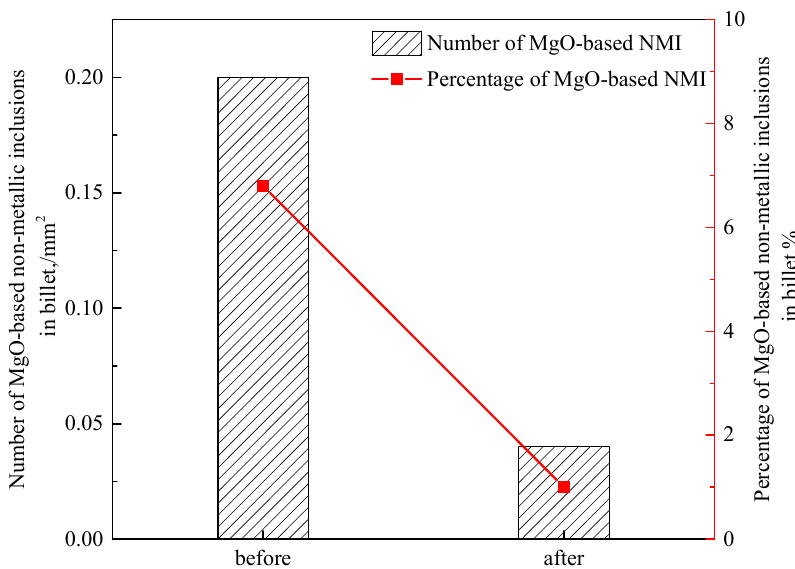
Figure 17. The number of MgO-based oxide inclusions in the billet.